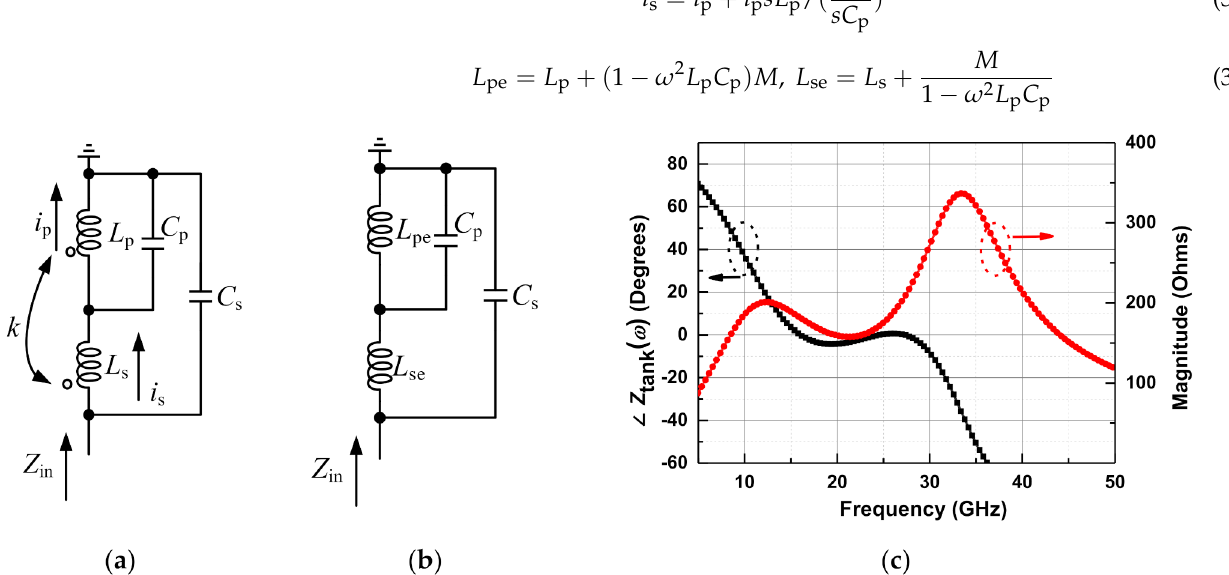
Figure 12. ( a ) AC equivalent circuit of the tank when the EM coupling between L p and L s is considered. ( b ) An equivalent model of (a). ( c ) Magnitude and phase response of the tank with the EM coupling taken into consideration, where L p , L s , C p , C s , R p , and k are 1 nH, 1 nH, 105 fF, 40 fF, 70 Ohms, and 0.3,